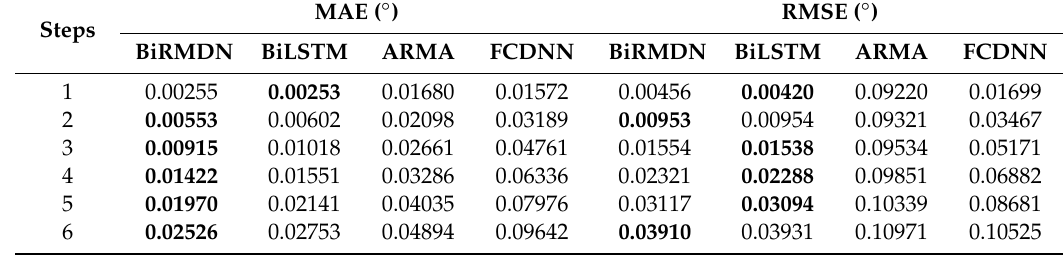
Table 2. Prediction performance of the comparative experiments.